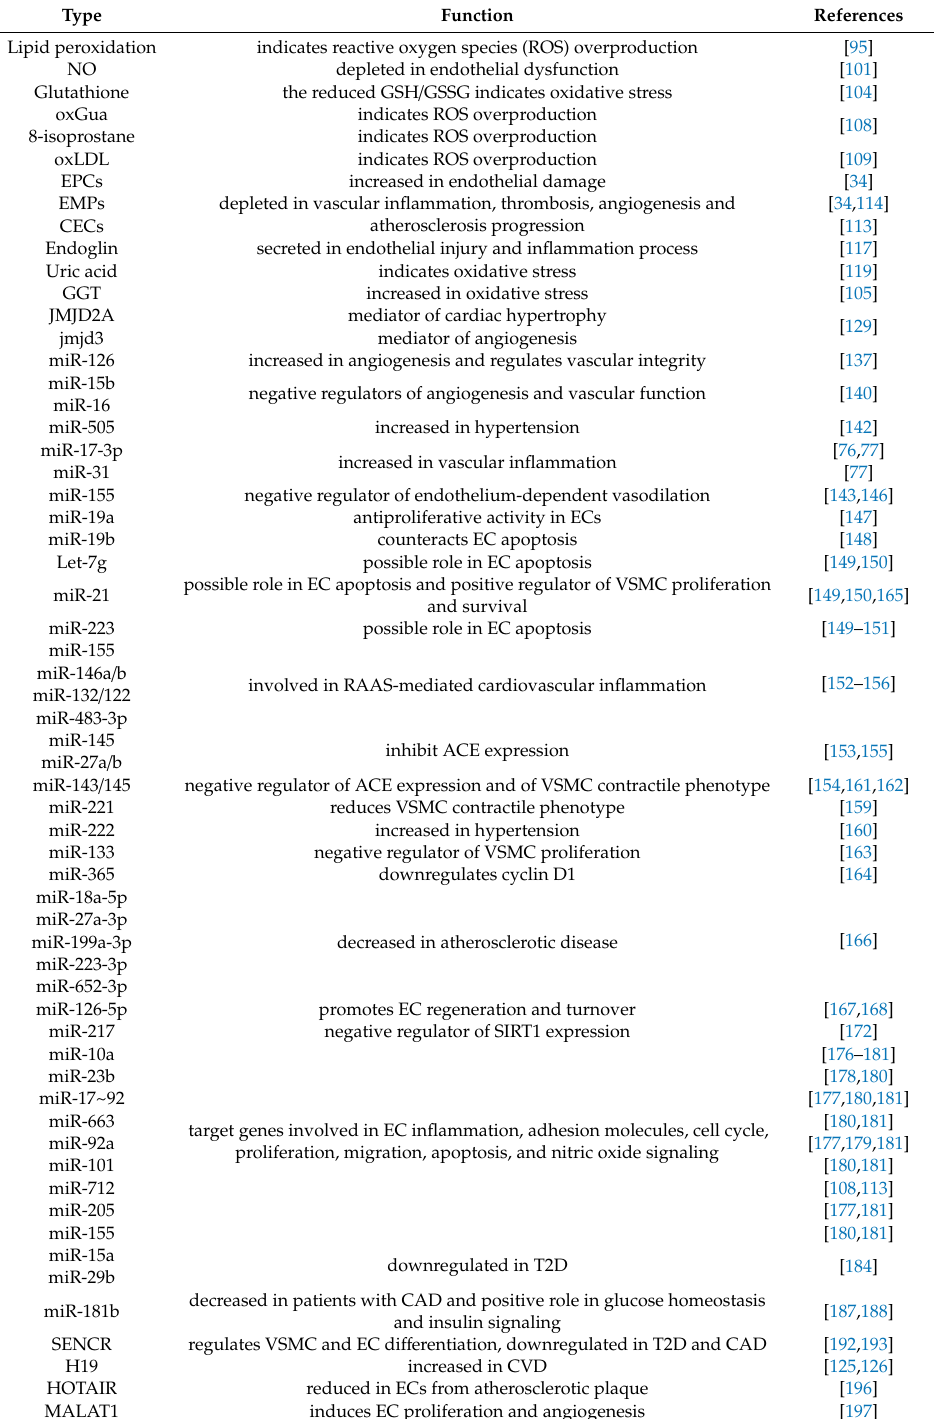
Table 2. Biomarkers of endothelial